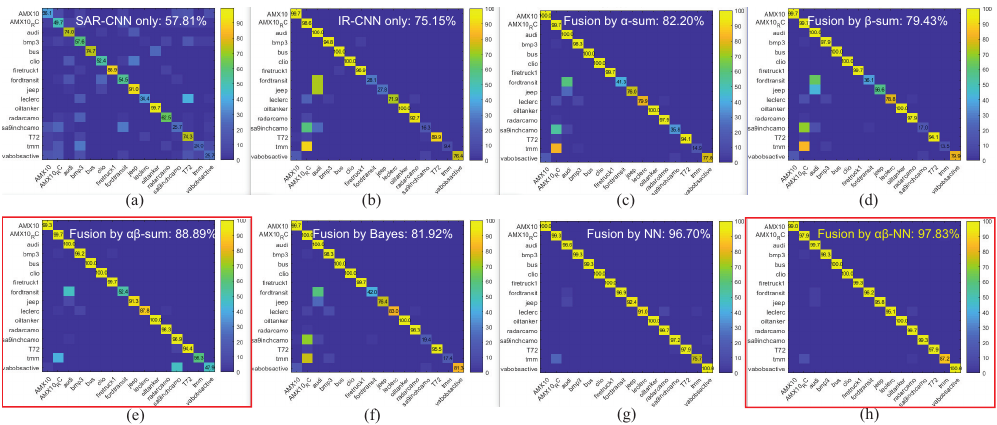
Figure 17. Confusion matrices at PSNR 16.3 dB: ( a ) SC; ( b ) IC; ( c ) α -sum; ( d ) β -sum; ( e ) αβ -sum (proposed linear fusion scheme I); ( f ) BF [57]; ( g ) NN; and ( h ) αβ -NN (proposed nonlinear fusion scheme II).